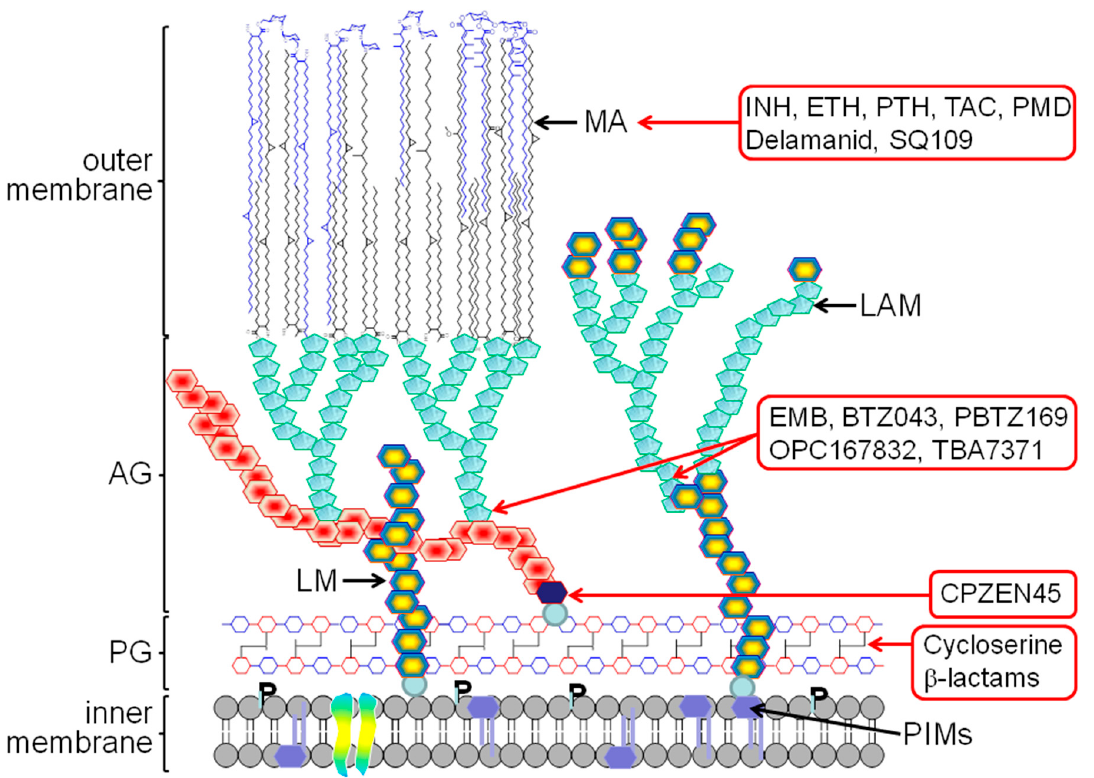
Figure 1. Illustration of the mycobacterial cell wall. The outermost layer of the cell wall, the capsule, is omitted. The cell wall components/sites inhibited by the tuberculosis (TB) drugs discussed herein are indicated. Abbreviations: AG, arabinogalactan; LAM, lipoarabinomannan; LM, lipomannan; MA, mycolic acids; PG, peptidoglycan; P, phospholipid; PIMs, phosphatidyl- myo -inositol mannosides; INH, isoniazid; ETH, ethionamide; PTH, prothionamide; TAC, thiacetazone; PMD, pretomanid; EMB, ethambutol.